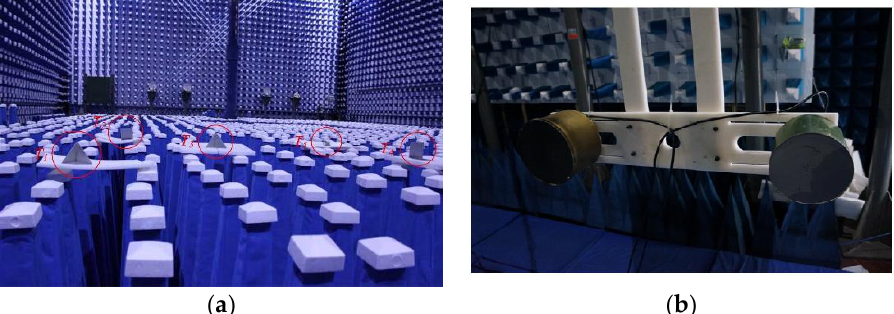
Figure 5. Experimental scene for CS-based stepped frequency radar imaging. ( a ) Five reflectors in the microwave chamber. ( b ) Transmitter and receiver antennas.